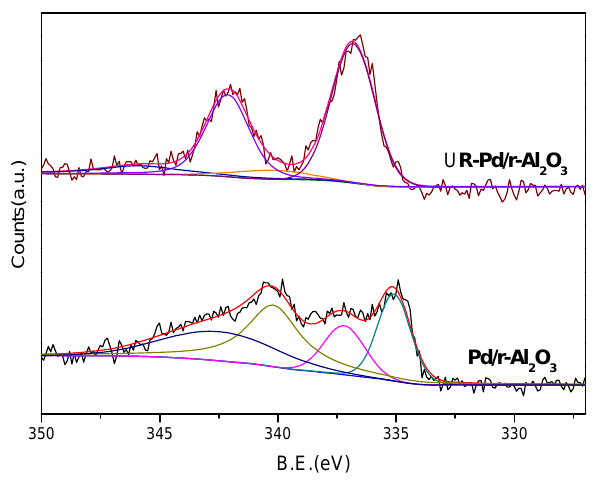
Figure 2. XPS spectra of samples.